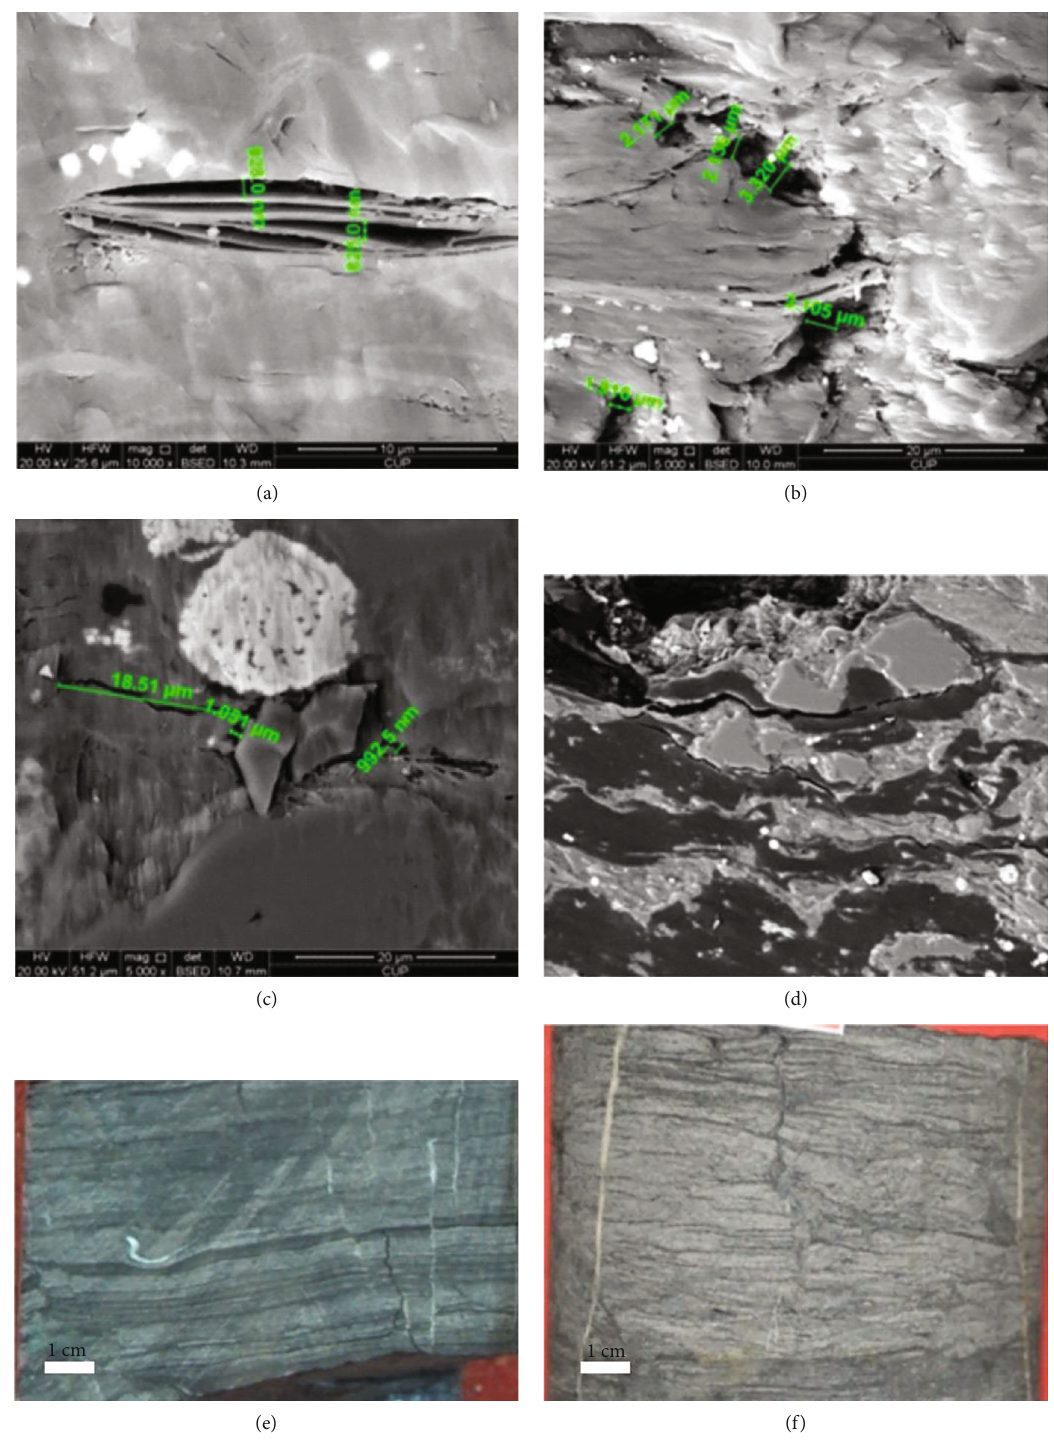
Figure 5: Types and characters of the fractures. (a) Mineral joint fracture, SEM, 911.77 m. (b) Dissolved fracture, SEM, 916m. (c) Microcracks between pyrite and mineral skeleton, SEM, 907m. (d) Microcracks between bands of organic matter, SEM, 1021.6m. (e) Tectonic fracture, 1047.90m. (f) Abnormal pressure fracture,